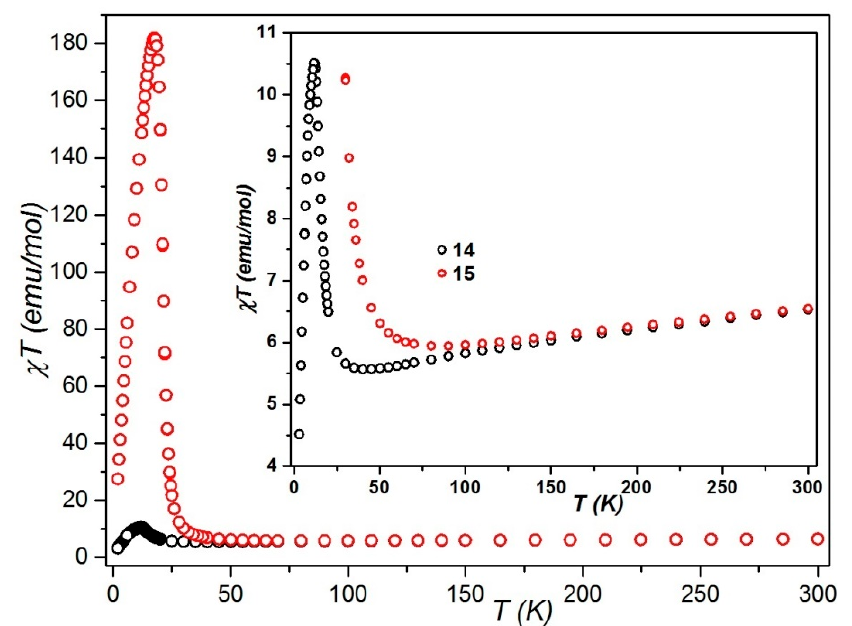
Figure 22. Magnetic dc plots for 14 and 15 . Temperature dependencies of χ T at H = 1000 Oe. Inset: zoomed-in magnetization versus field at T = 2 K [56].